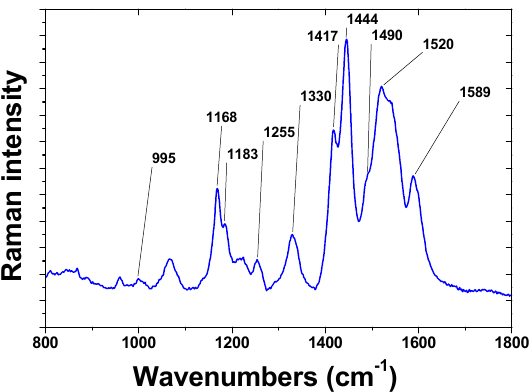
Figure 6. Raman spectrum of the organic film deposited on a AuNPs/ITO electrode by plasmon induced grafting from a ADPA diazonium solution. .